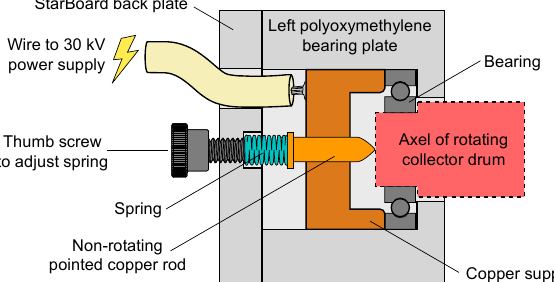
Figure 3. A diagram of the high voltage contact to the high-speed rotating collector drum. The high-voltage supply wire is soldered to a copper support which makes contact with the spring-loaded non-rotating pointed copper rod and the outer races of the bearing. The non-rotating pointed copper rod makes contact to the center of the collector drum’s axel.